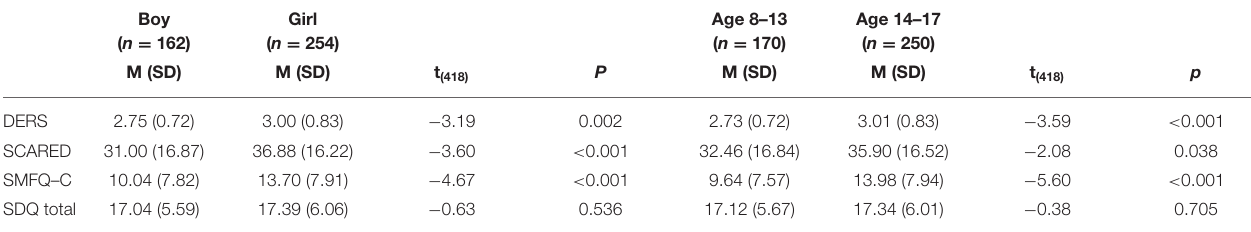
TABLE 3 | Mental health variables in children and adolescents by gender and